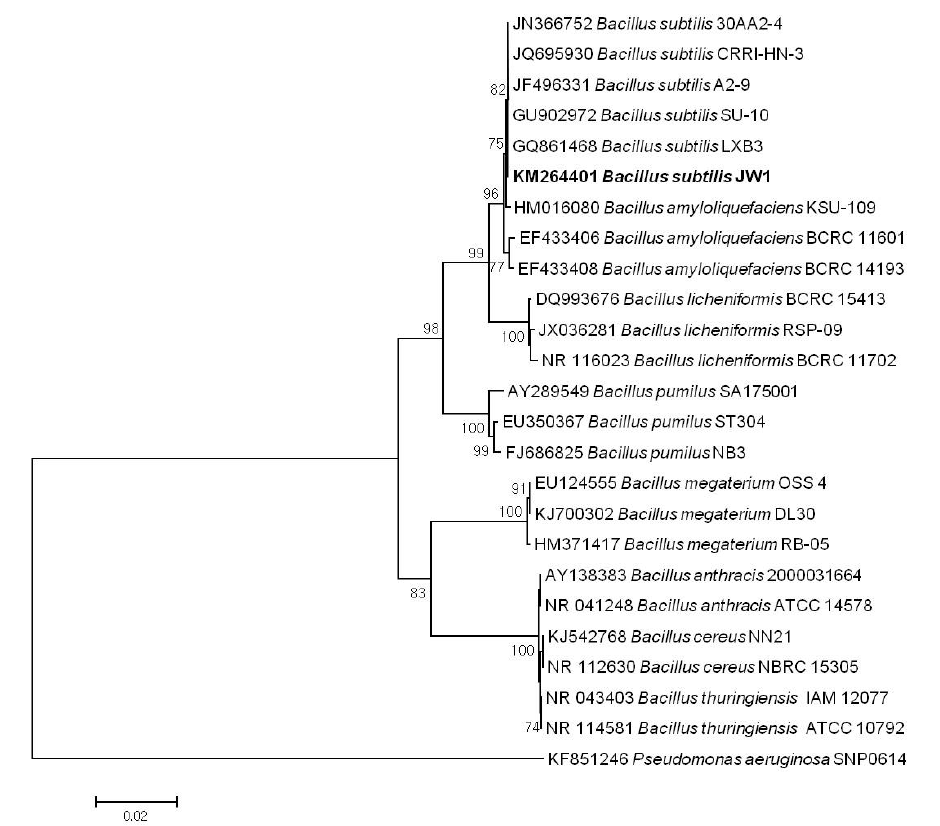
Fig. 5: The evolutionary history was inferred by using the Maximum Likelihood method based on the Tamura-Nei model. Evolutionary analysis were con- ducted in MEGA v. 6.1. The phylogenetic analysis was performed by constructing Neighbour Joining (NJ) tree using 16S rDNA gene sequences from isolate JW1and related bacterial